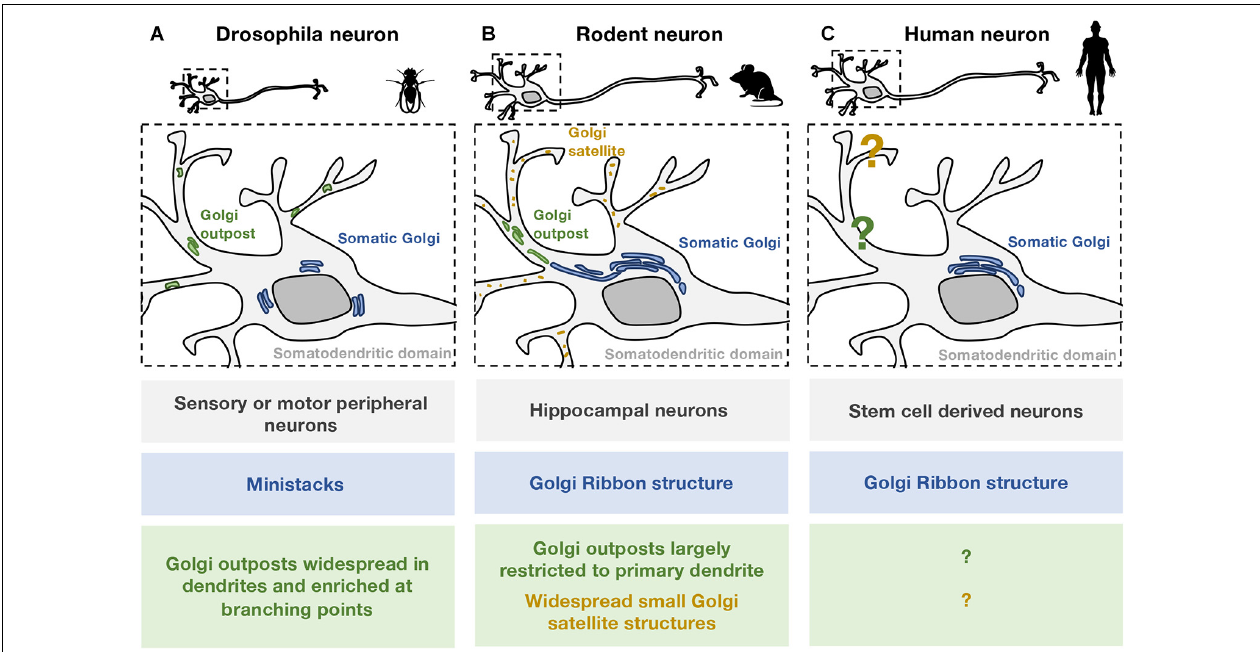
FIGURE 1 | Comparison of somatic and dendritic Golgi structures in different neuronal models. The organization of Golgi structures in (A) Drosophila , (B) rodent, and (C) human neurons are illustrated. Zebrafish neurons are not included as the Golgi structures are not well defined. (A) In Drosophila cell models, most neurons examined are from the peripheral nervous system. In these neurons, the somatic Golgi apparatus (blue) appears as mini-stacks or “ring”-like stacks. GOs (green) are widespread in the dendritic network including the distal dendrites, and are particularly enriched at branching points. Both single- and multi-compartmented Golgi outposts are present in the Drosophila dendritic network. (B) In rodent models, most neurons examined are cultured embryonic hippocampal neurons. In these neurons, the somatic Golgi apparatus is a Golgi ribbon (blue), and appears to extend into the primary dendrite. Stacked GOs (green) are largely restricted to one primary dendrite and are often found in the proximal region. Smaller, non-stacked Golgi satellite structures (orange) are identified in the dendritic arborisation of rodent neurons. (C) In human neurons, the arrangement of secretory organelles, including the Golgi apparatus, is not well defined. A dendritic Golgi in human neurons has yet to be identified. Given the structural differences observed in Drosophila (A) and rodent (B) neurons, conclusions about human neurons should be drawn carefully especially in relation to “Golgi